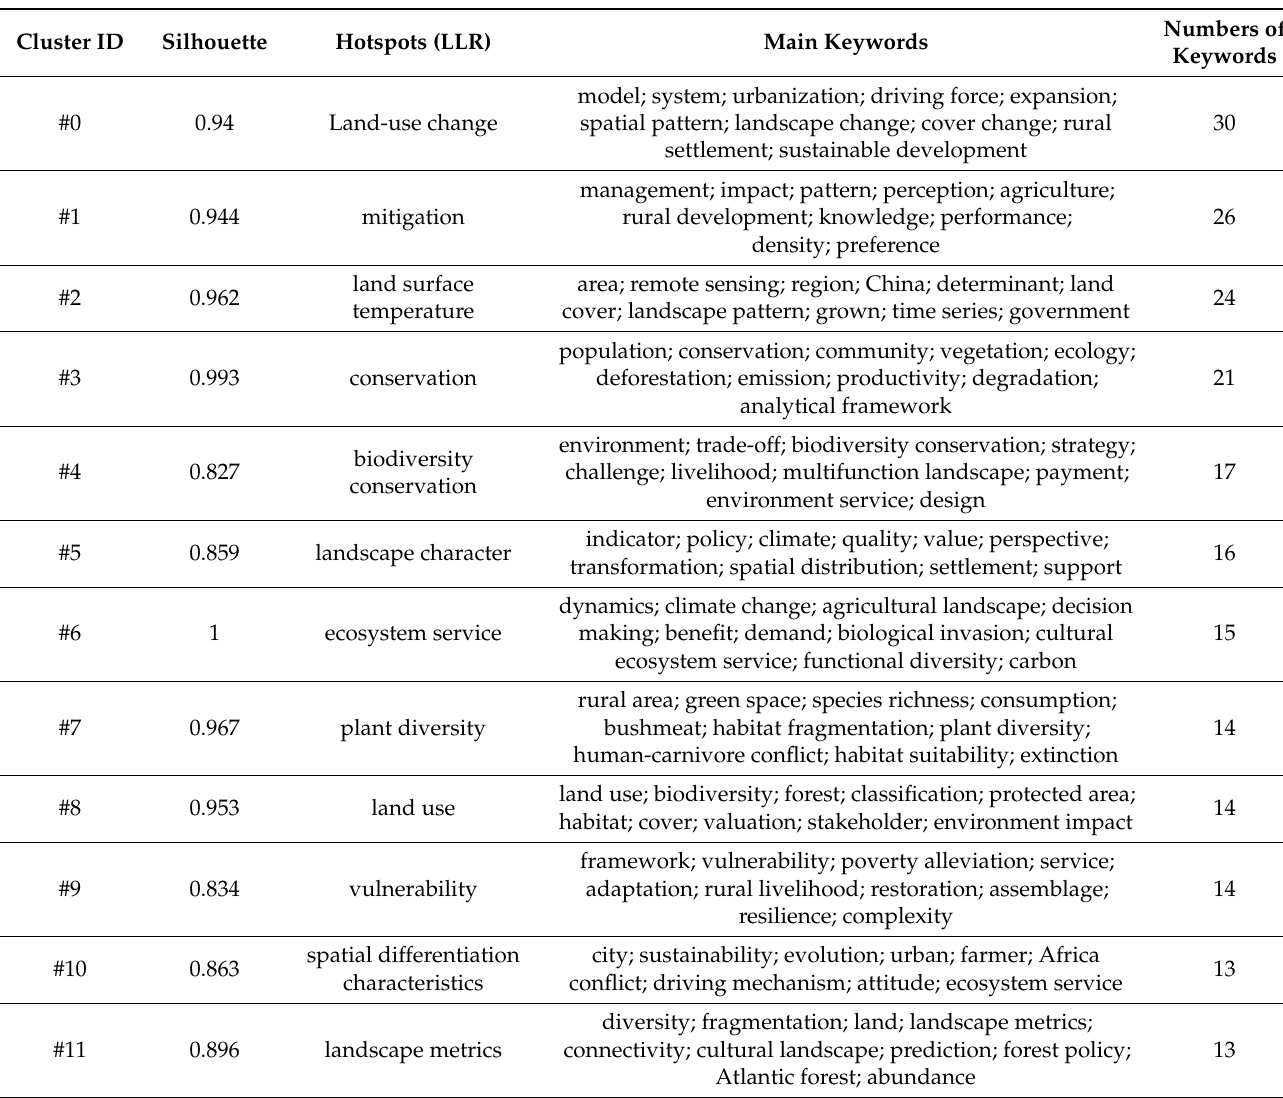
Table A2. Analysis of research topics in developing countries based on